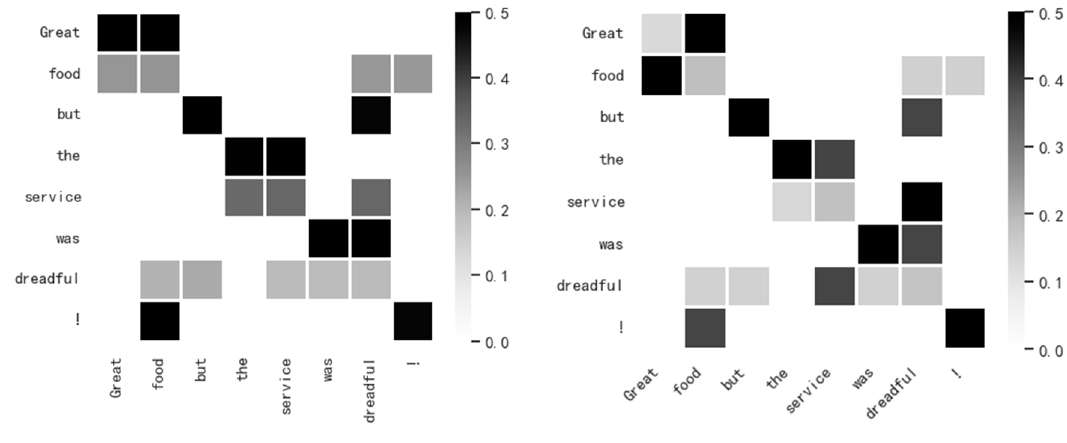
Figure 6. A tt ention visualisation.